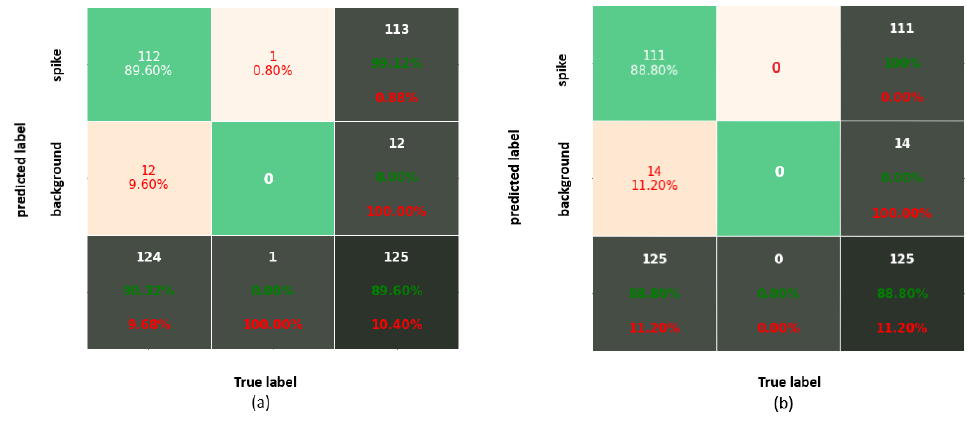
Figure 5. Confusion matrix corresponding to IoU = 0.75 for ( a ) Faster-RCNN and ( b )